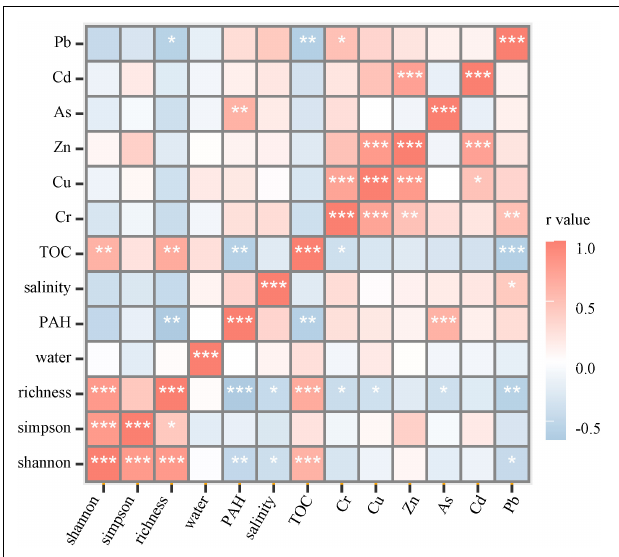
FIGURE 2 | The spearman correlation in bacterial diversity and soil environmental factors. The * stands for the p value. *, p < 0.05; **, p < 0.01; ***, p <